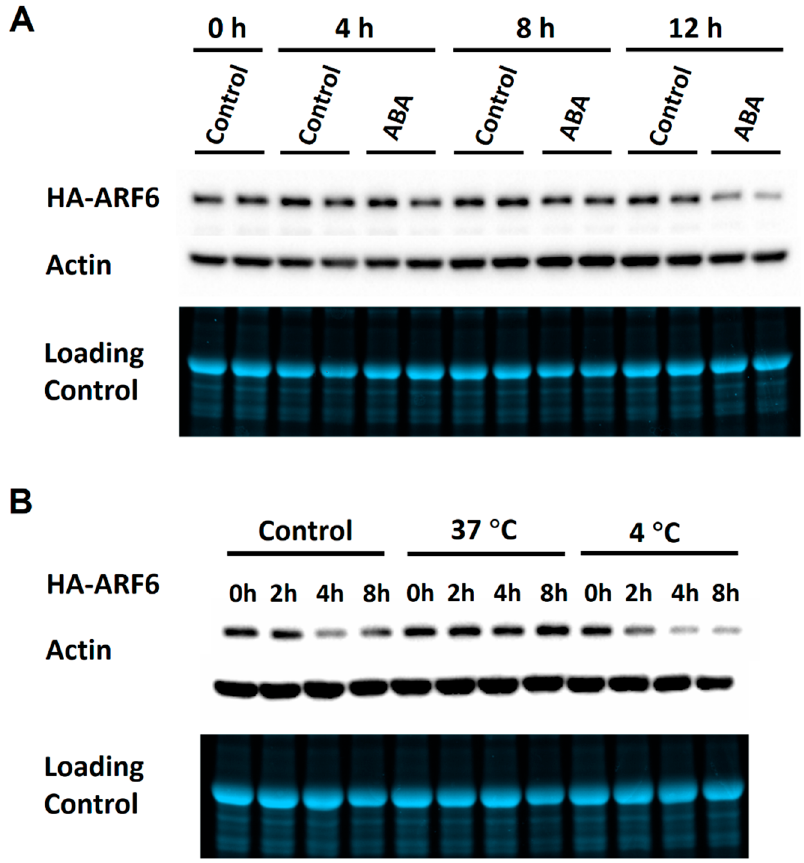
Figure 3. Time-course analysis of ABA and temperature treatments on HA-ARF6 protein levels. Transgenic HA-ARF6 seedlings were grown vertically in Petri plates. For ABA treatments, seedlings (10 to 11-day old) were transferred to treatment plates containing a piece of filter paper and 5 mL half-strength MS with or without a treatment reagent, with each plate having about 25 seedlings. For temperature treatments, seedlings grown on one-half MS plates were treated directly at the temperatures with the control at 22 °C. After the treatments, protein samples were used for electrophoresis (30 µ g per lane) in the Bio-Rad TGX mini-gel, followed by western analysis. In each subfigure, the first row shows the western blot with an anti-HA antibody, the second row shows the western blot with an anti-actin antibody and the third row shows the gel image. The treatment conditions are indicated directly above the lanes. ( A ) ABA treatments. Seedlings were treated in control (one-half MS medium plus 0.1% ethanol) and 50 µ M ( + )-ABA for the indicated hours. Each time point had two replicate samples. ( B ) Temperature treatments. Seedlings were treated for the indicated hours with the control at 22 °C.